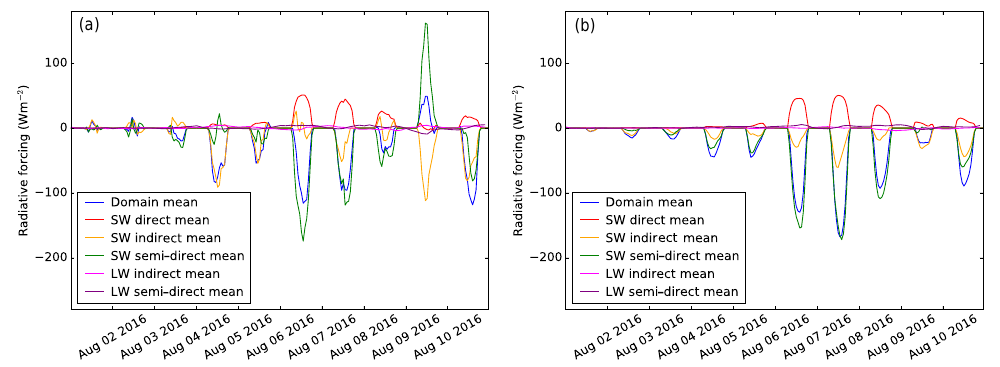
Figure 16. Decomposition of the radiative effects of biomass burning smoke in the regional model domain in the global model (a) and the regional model (b) into the direct, indirect and semi-direct components in the short- and longwave bands according to the recommendations by (Ghan et al., 2012).